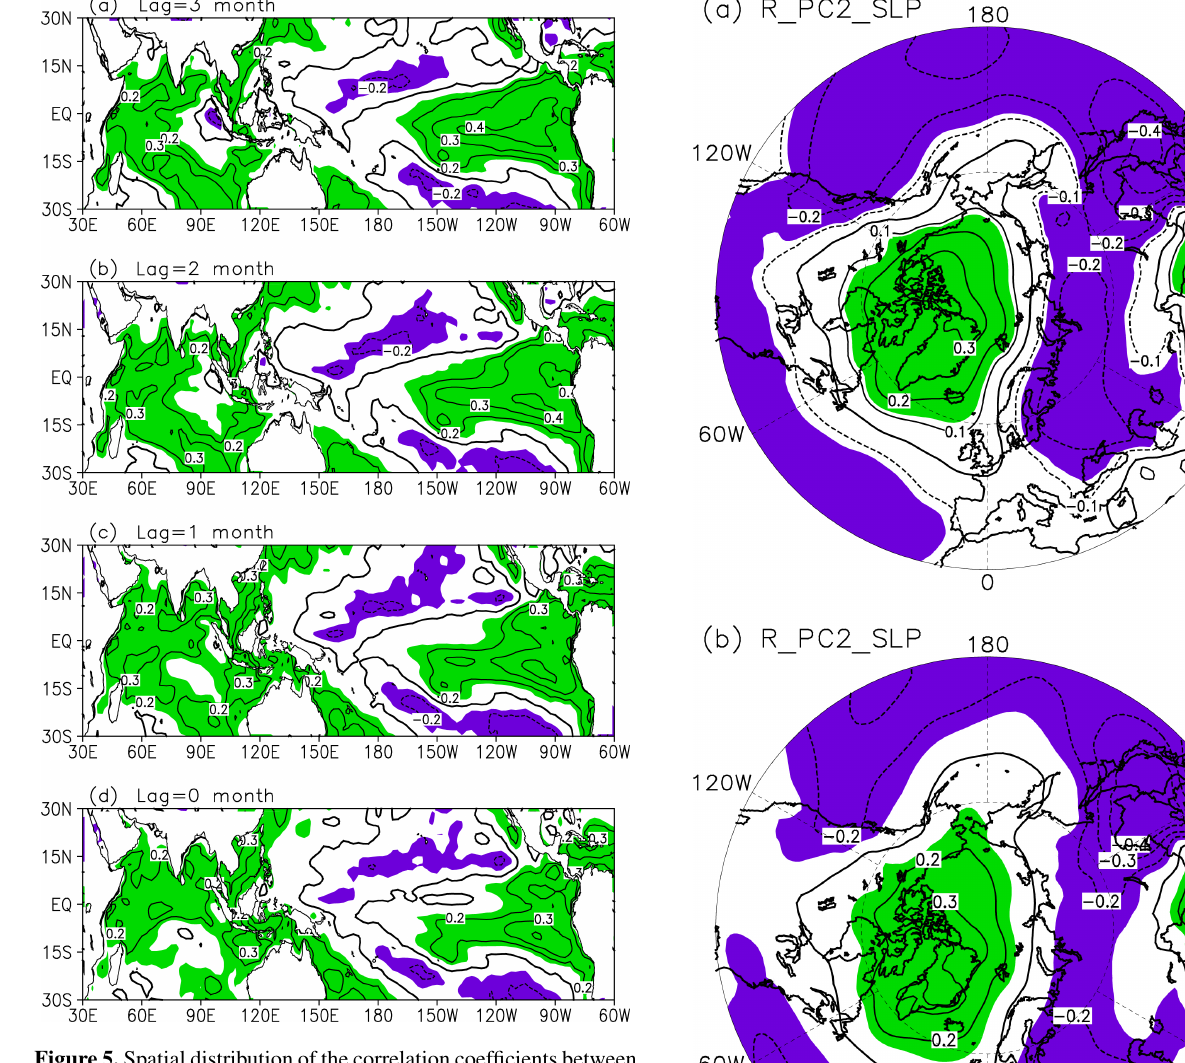
Figure 5. Spatial distribution of the correlation coefficients between the monthly sea surface temperature and PC1 for PC1 lagging for (a) 3 months, (b) 2 months, (c) 1 month, and (d) simultaneous. Color shading indicates significance at the 0.05 level.